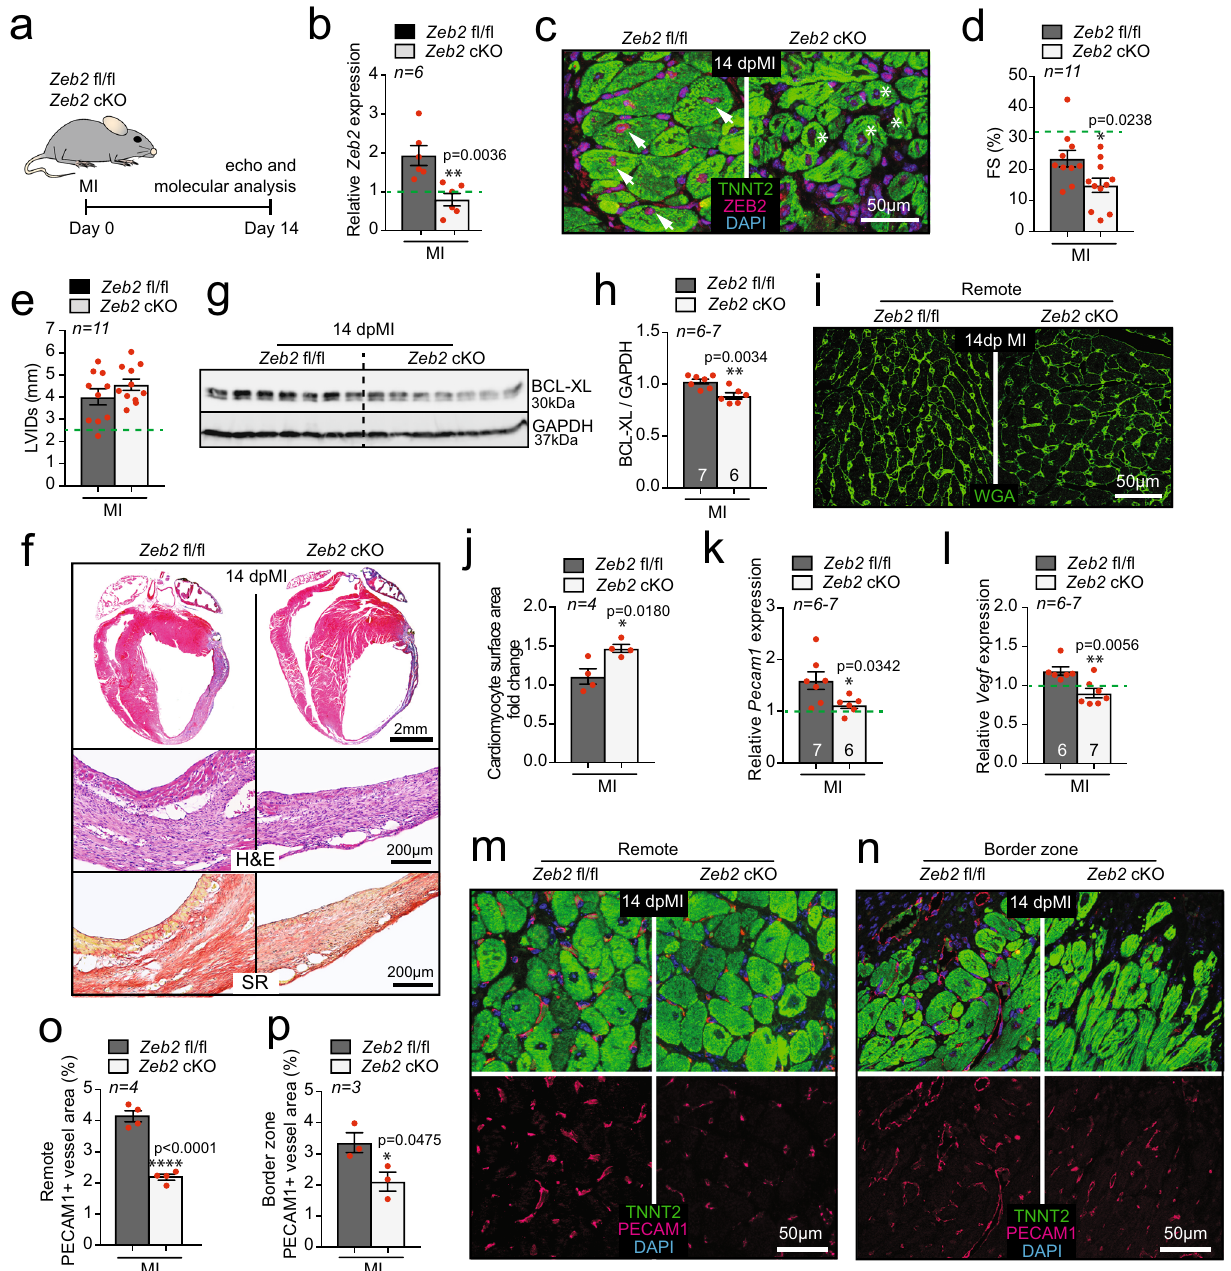
Fig. 2 Cardiomyocyte-speci fi c deletion of Zeb2 impairs infarct healing. a Study design. b mRNA expression levels of Zeb2 in Zeb2 fl / fl and Zeb2 cKO mice post-surgery. c Immuno fl uorescence for ZEB2, TNNT2, and DAPI of cardiac sections from Zeb2 fl / fl and Zeb2 cKO mice 14 dpMI. d – e Quanti fi cation of d fractional shortening (FS) and e left ventricular internal diameter in systole (LVIDs) from Zeb2 fl / fl and Zeb2 cKO mice post-surgery. f Representative images of cardiac four-chamber view (top panel), sections from infarcted areas stained with either H&E (second panel) or SR (third panel). g Representative WB for BCL-XL in tissue from Zeb2 fl / fl and Zeb2 cKO 14 dpMI and h its quanti fi cation. i WGA staining to measure cardiomyocyte surface area and j its quanti fi cation. k , l mRNA expression levels of k Pecam1 and l Vegf in Zeb2 fl / fl and Zeb2 cKO mice post-surgery. m , n Immuno fl uorescence for PECAM1, TNNT2, and DAPI in m remote and n border zone. o , p quanti fi cation of PECAM1 positive blood vessel areas in histological sections of hearts from Zeb2 fl / fl and Zeb2 cKO mice 14 dpMI in ( m , n ). Green dashed line indicates sham Zeb2 fl / fl control. H&E indicates Hematoxylin and Eosin, SR indicates Sirius Red. White arrows show ZEB2 positive cardiomyocytes. White stars show ZEB2 negative cardiomyocytes. Data are represented as mean ± SEM, * p < 0.05, ** p < 0.01, **** p < 0.0001, each dot indicates a biological replicate, n is indicated in fi gures. Comparison of two groups was performed with the unpaired, two-tailed Student ’ s t -test between Zeb2 cKO vs Zeb2 fl / fl post-MI ( b , d , e , h , j , k , l , o , p ). Source data are provided as a Source Data fi le. (Supplementary Fig. 4b-c). Pathway analysis showed that (-0,2 Log2 fold change) downregulated and 1599 (0,2 Log2 fold upregulated genes were mainly linked to metabolic pathways change) upregulated genes (Supplementary Fig. 4a and Supple- (Supplementary Fig. 4d), whereas downregulated genes were mentary Data 3). The differential expression of the top regulated involved in, among others, focal adhesion, PI3K-Akt signaling, genes could be con fi rmed by qPCR in a larger sample set ( n = 7) NATURE COMMUNICATIONS| (2021) 12:84